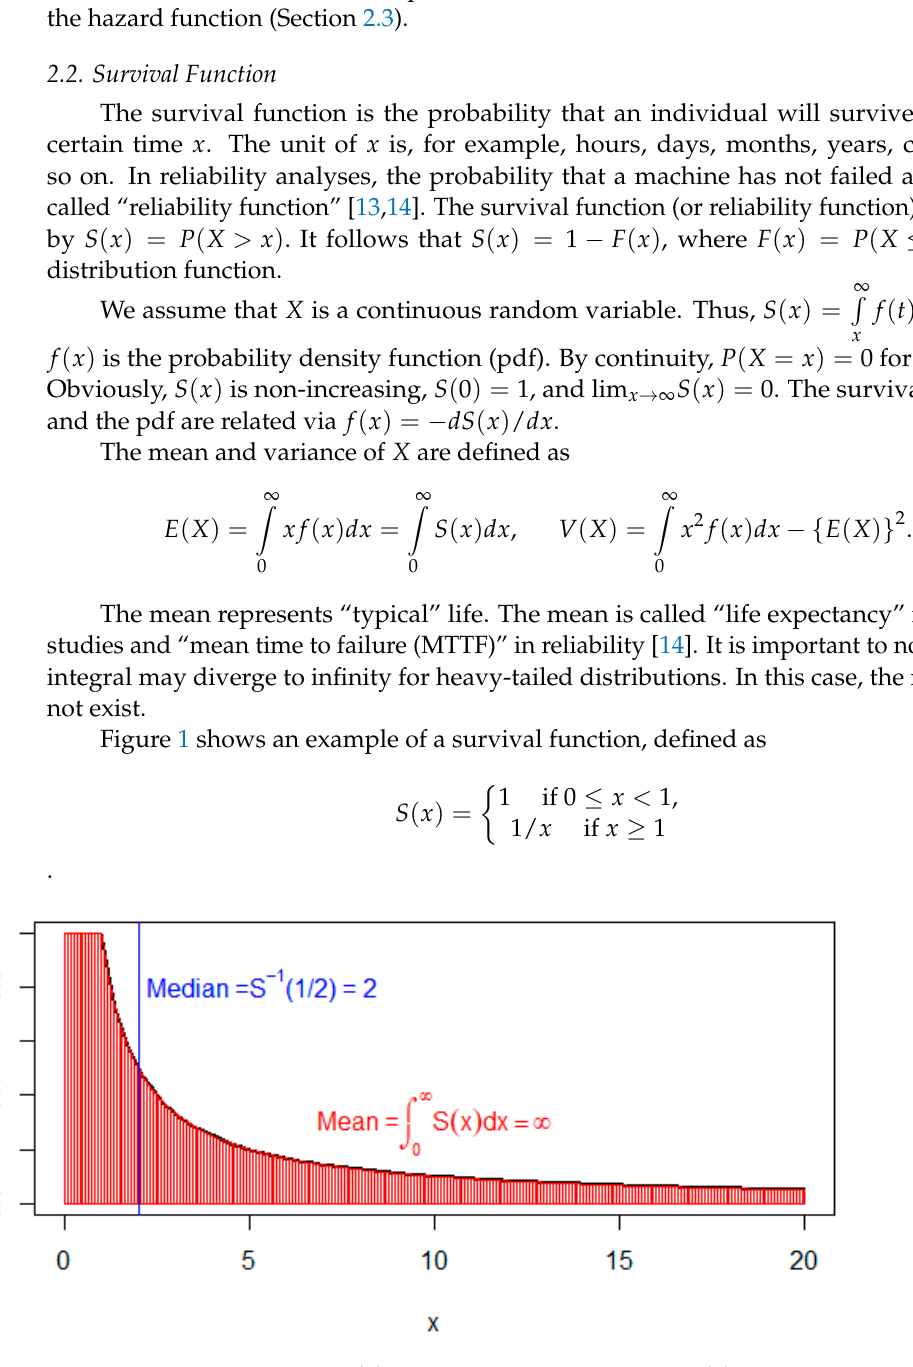
Figure 1. A survival function 𝑆(𝑥) = 1/𝑥 , 𝑥 ≥ 1 . The area under 𝑆(𝑥) is shown in red color.